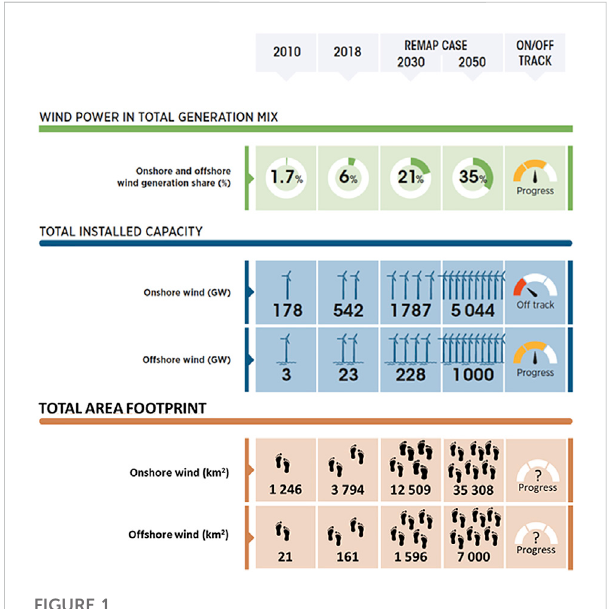
FIGURE 1 Wind roadmap to 2050: tracking progress of wind energy to achievethe global energy transformation (source: IRENA 2019(top two panels)). Area footprints (lower panel) are calculated from the installed capacity, assuming an area requirement of 0.7 ha/MW.